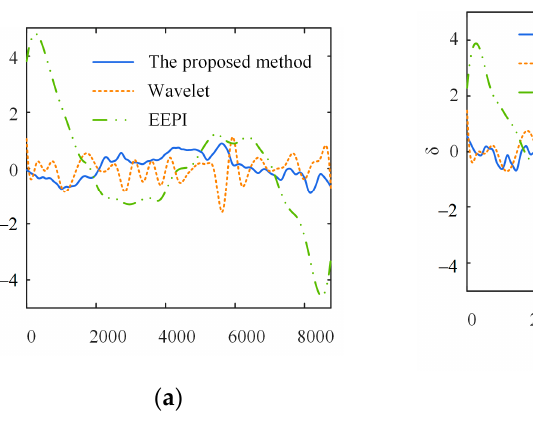
Figure 14. Separation error under different degrees of noise (one year): ( a ) e p = 5%; ( b ) e p = 10%; . . ( c ) e p =